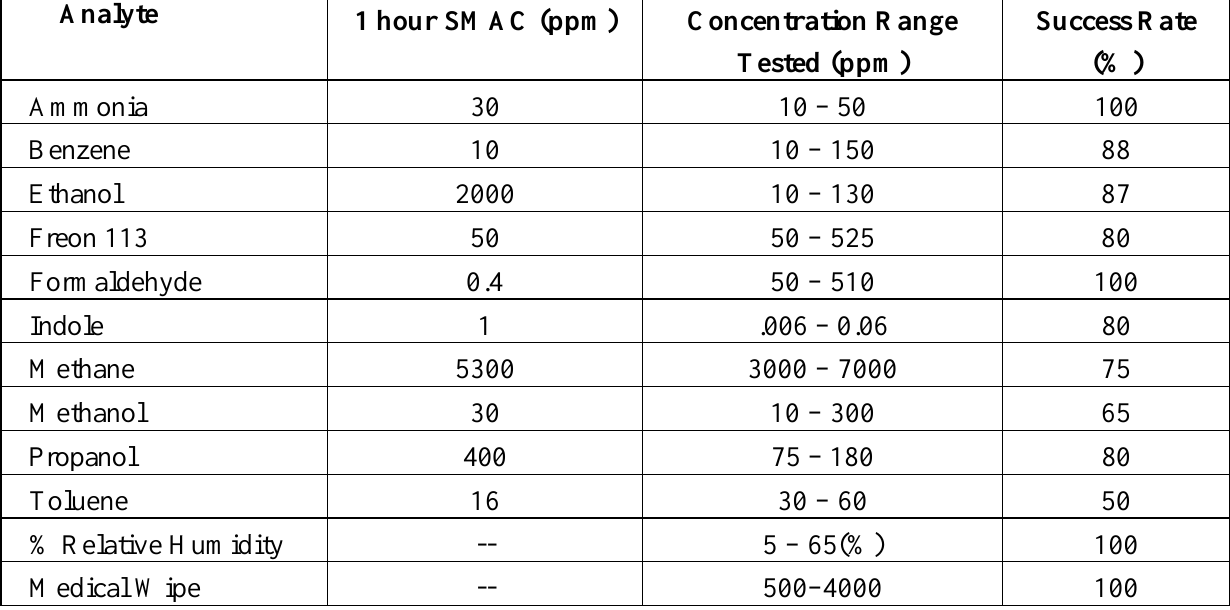
Table 1. Analytes, concentrations and success rates for identifying and quantifying single